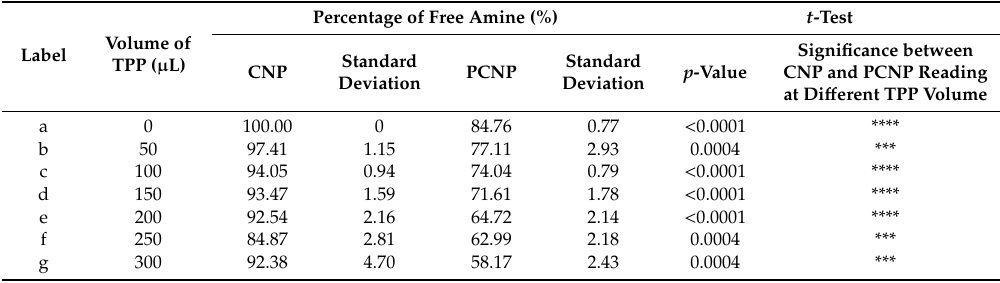
Table 1. Percentage of free amine and significancy test ( t -test) between chitosan nanoparticles (CNP) and PCNP at di ff erent sodium tripolyphosphate (TPP) volume. (a) significant **** with a p value of < 0.0001, (b) significant *** with a p value of 0.0004, (c) significant **** with a p value of <